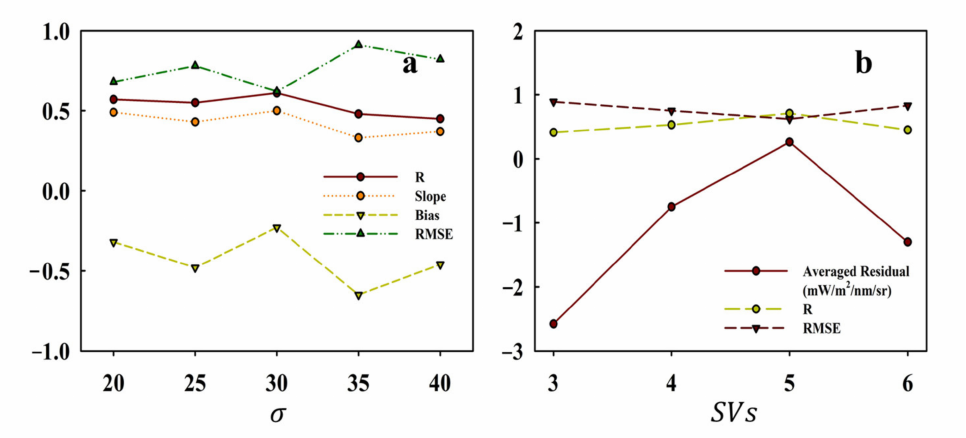
Figure 7. Sensitivity analysis results of different σ ( a ) and SVs ( b